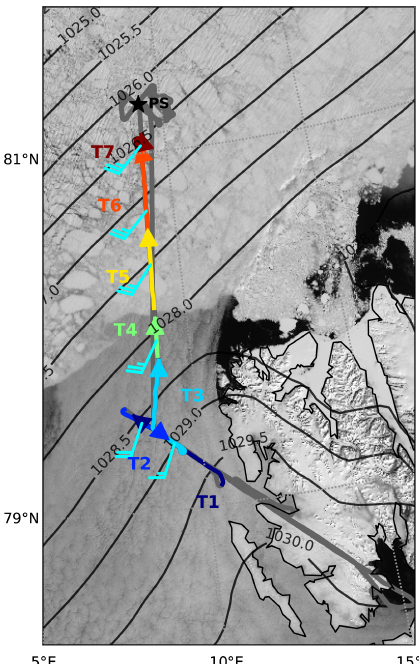
Figure 5. Polar 6 flight track on 2 June 2017 overlaid on the MODIS satellite image. T1–T7 represent descents and ascents of the aircraft. The wind barbs are showing the wind speed and di- rection averaged over the profile segments within the ABL. Isobars represent the mean sea level pressure field based on the ERA5 re- analysis.